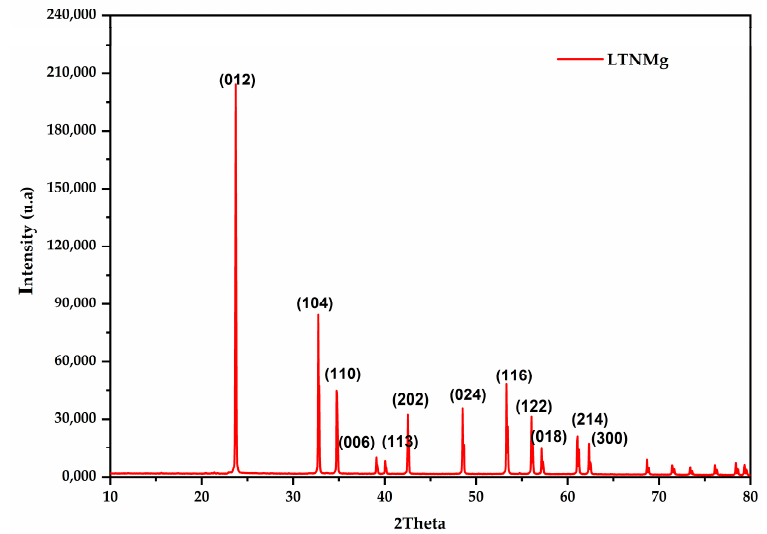
Figure 1. XRD pattern of Li 0.95 Ta 0.76 Nb 0.19 Mg 0.15 O 3 .